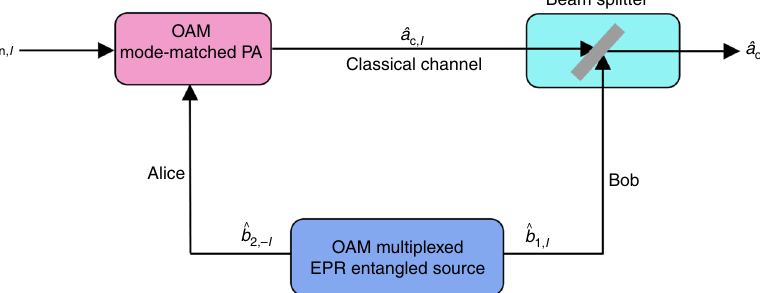
Fig. 1 Schematic of parallel all-optical teleportation. Alice, sender; Bob receiver; OAM orbital angular momentum, EPR entangled source Einstein- Podolsky-Rosen entangled source; PA parametric ampli fi er, ^ a state for one OAM-multiplexed channel; ^ b 1 ;‘ and ^ b 2 ; (cid:2) ‘ are the annihilation operators associated with an OAM mode in EPR 1 and EPR 2 beams,